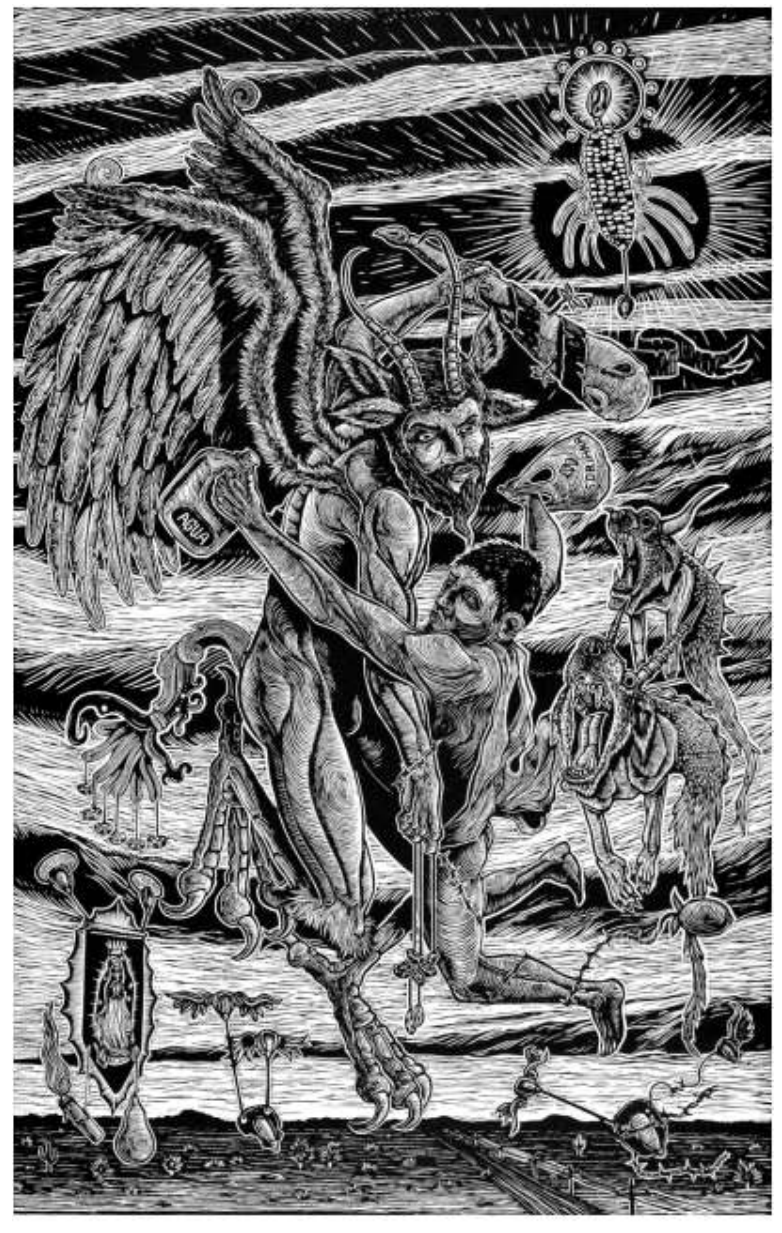
Juan de Dios Mora, Abduction of the Immigrant , 2009, linocut, 22 x 30